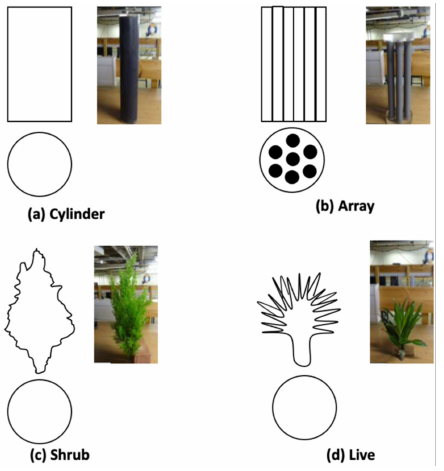
Figure 3. The first experimental group of vegetation analogs with a diagrammatic sketch and picture; the circle under each sketch represents the maximum diameter of the corresponding vegetation